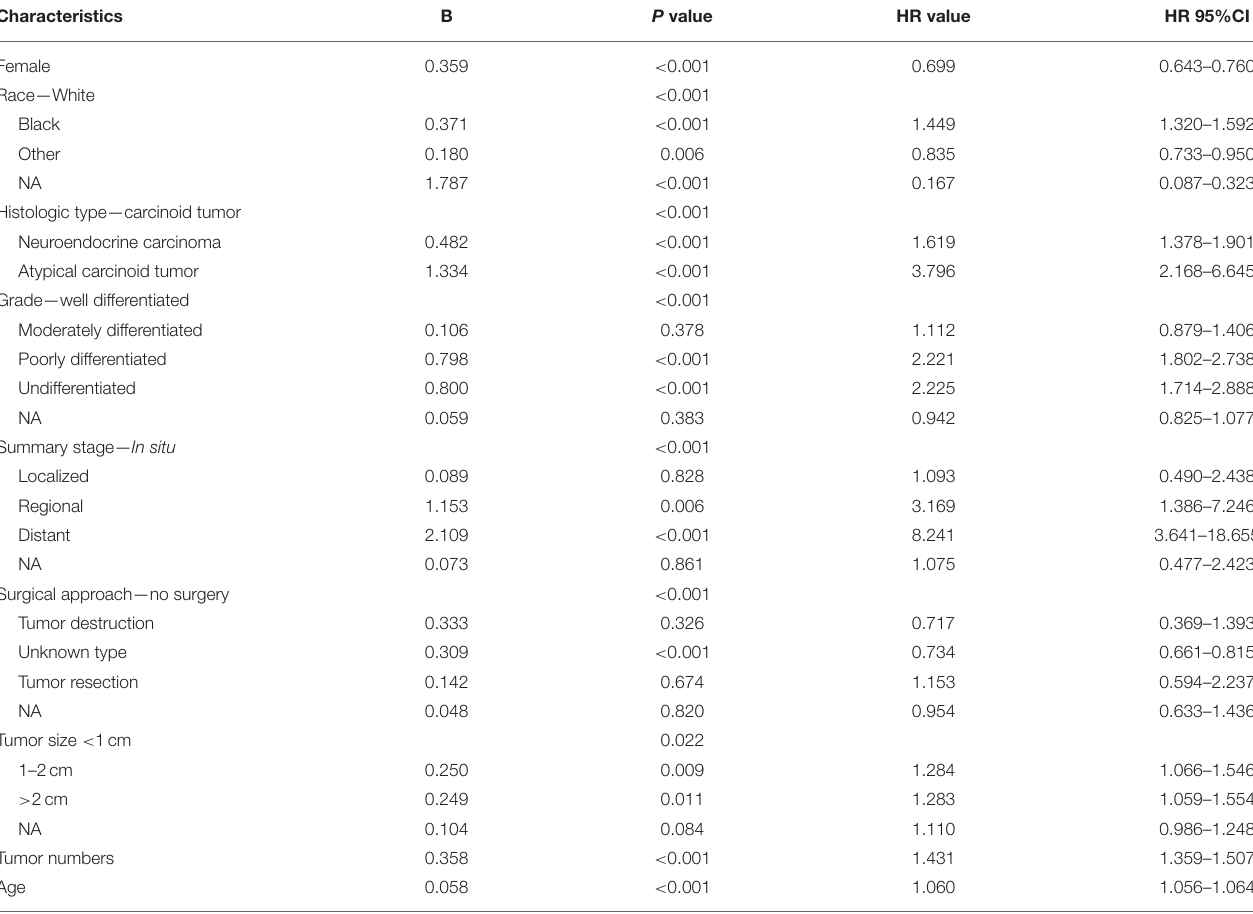
TABLE 2 | Multivariable Cox regression